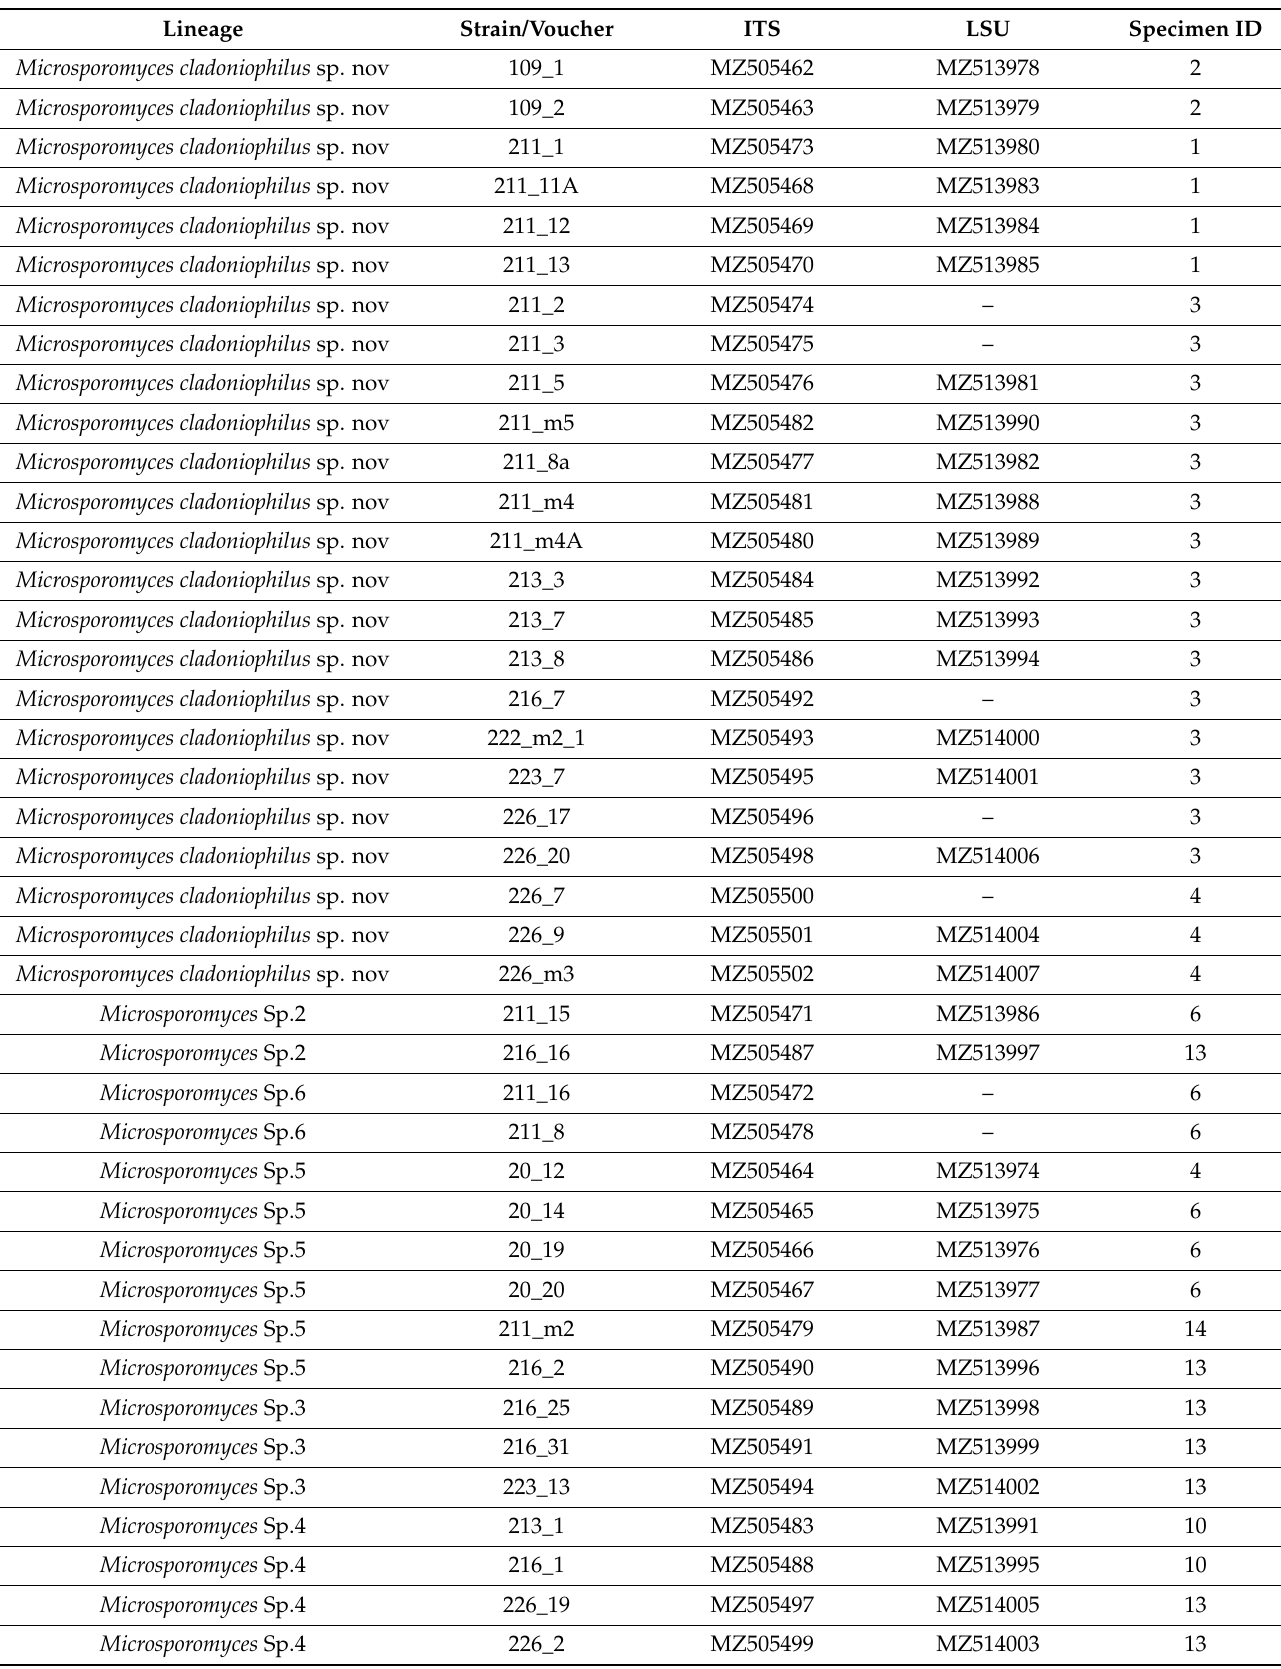
Table 2. List of the sequences from obtained cultures and their Genbank accession